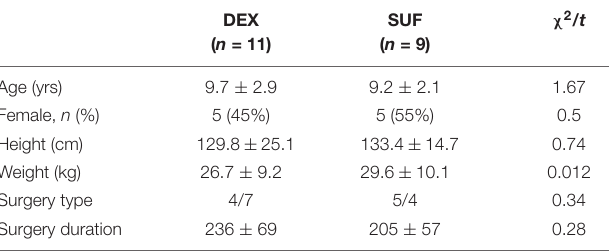
TABLE 2 | Demographic characteristics of patients aged > 6 years old in the SUF and DEX experimental